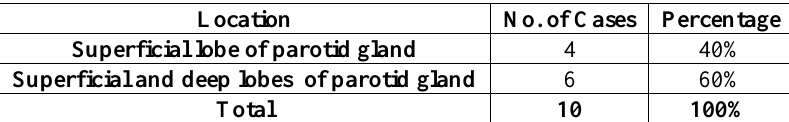
Table 3: Distribution of benign parotid tumors